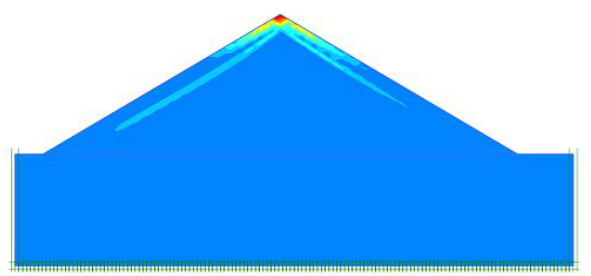
Figure 12: Theoretical destruction mechanism of a complete flood embankment model, corresponding to the value of the stability factor F = 1.07.